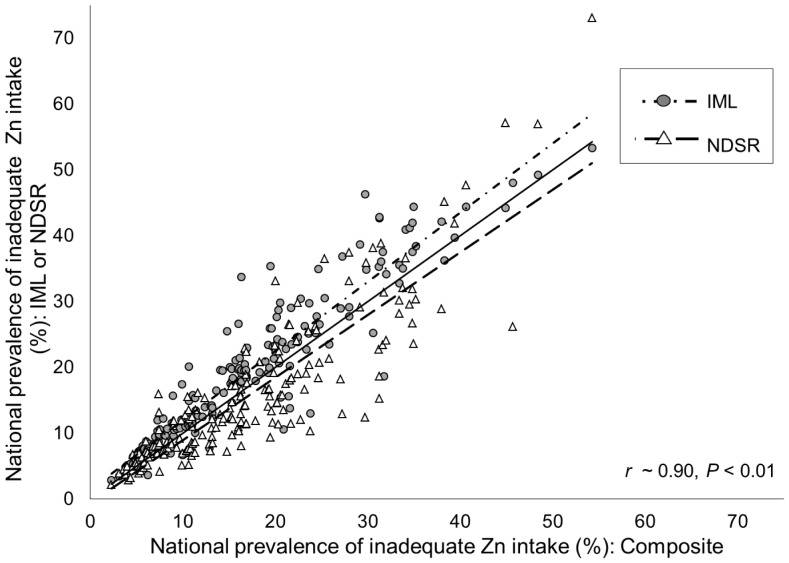
Associations between the national prevalence of inadequate zinc intake as estimated by different nutrient composition databases.Estimates are based on the Composite, WorldFood System International Mini-list (IML) and Nutrition Data System for Research (NDSR) nutrient composition databases. Physiological requirements developed by the International Zinc Nutrition Consultative Group (IZiNCG), the Miller equation for absorbed zinc and a 25% inter-individual CV in intake are constant across estimates. The dashed lines represent the linear regression lines and the solid line represents the line of identity (intercept = 0, slope = 1). N = 188 countries.